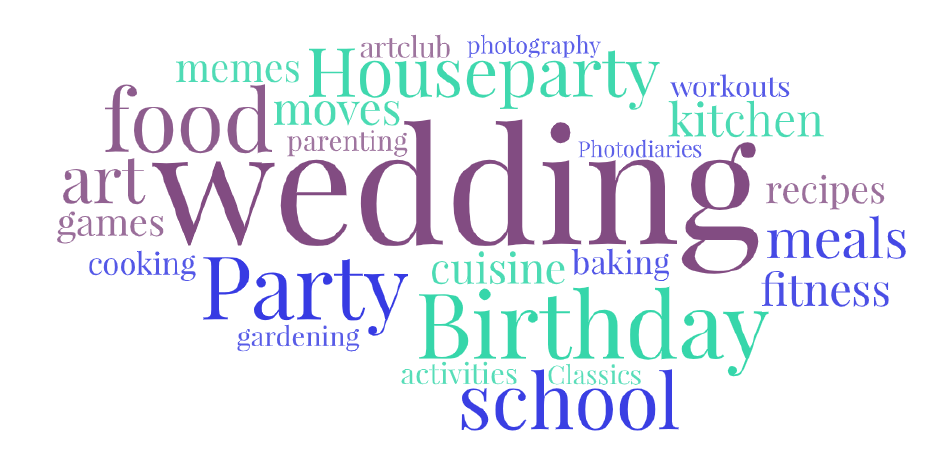
Image 3: Wordcloud of Distinctive